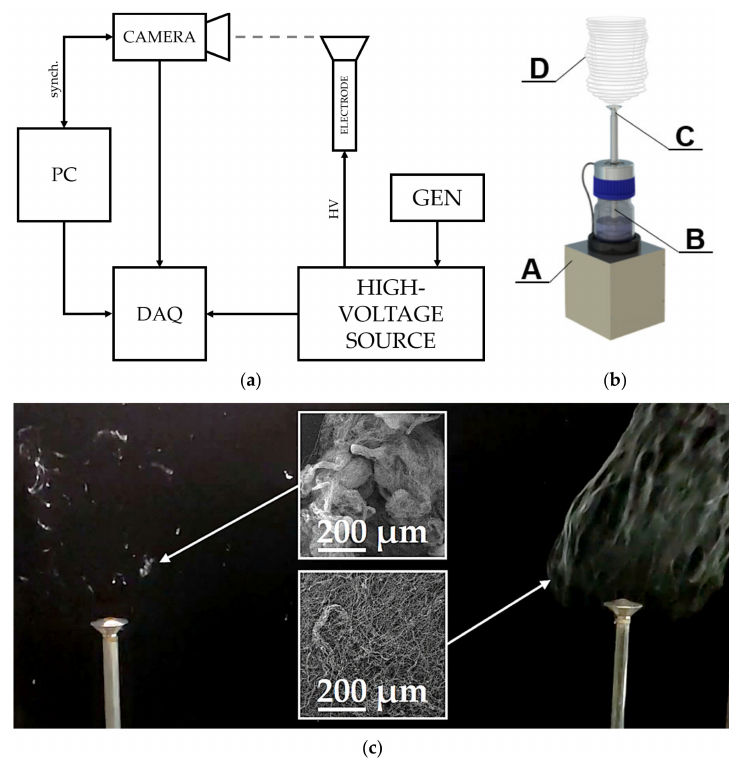
Figure 1. Scheme of the experimental setup ( a ) consisting of an electrode with a screw pump containing the polymeric solution, a high-voltage power source (TREK) with a signal generator (GEN-Owon